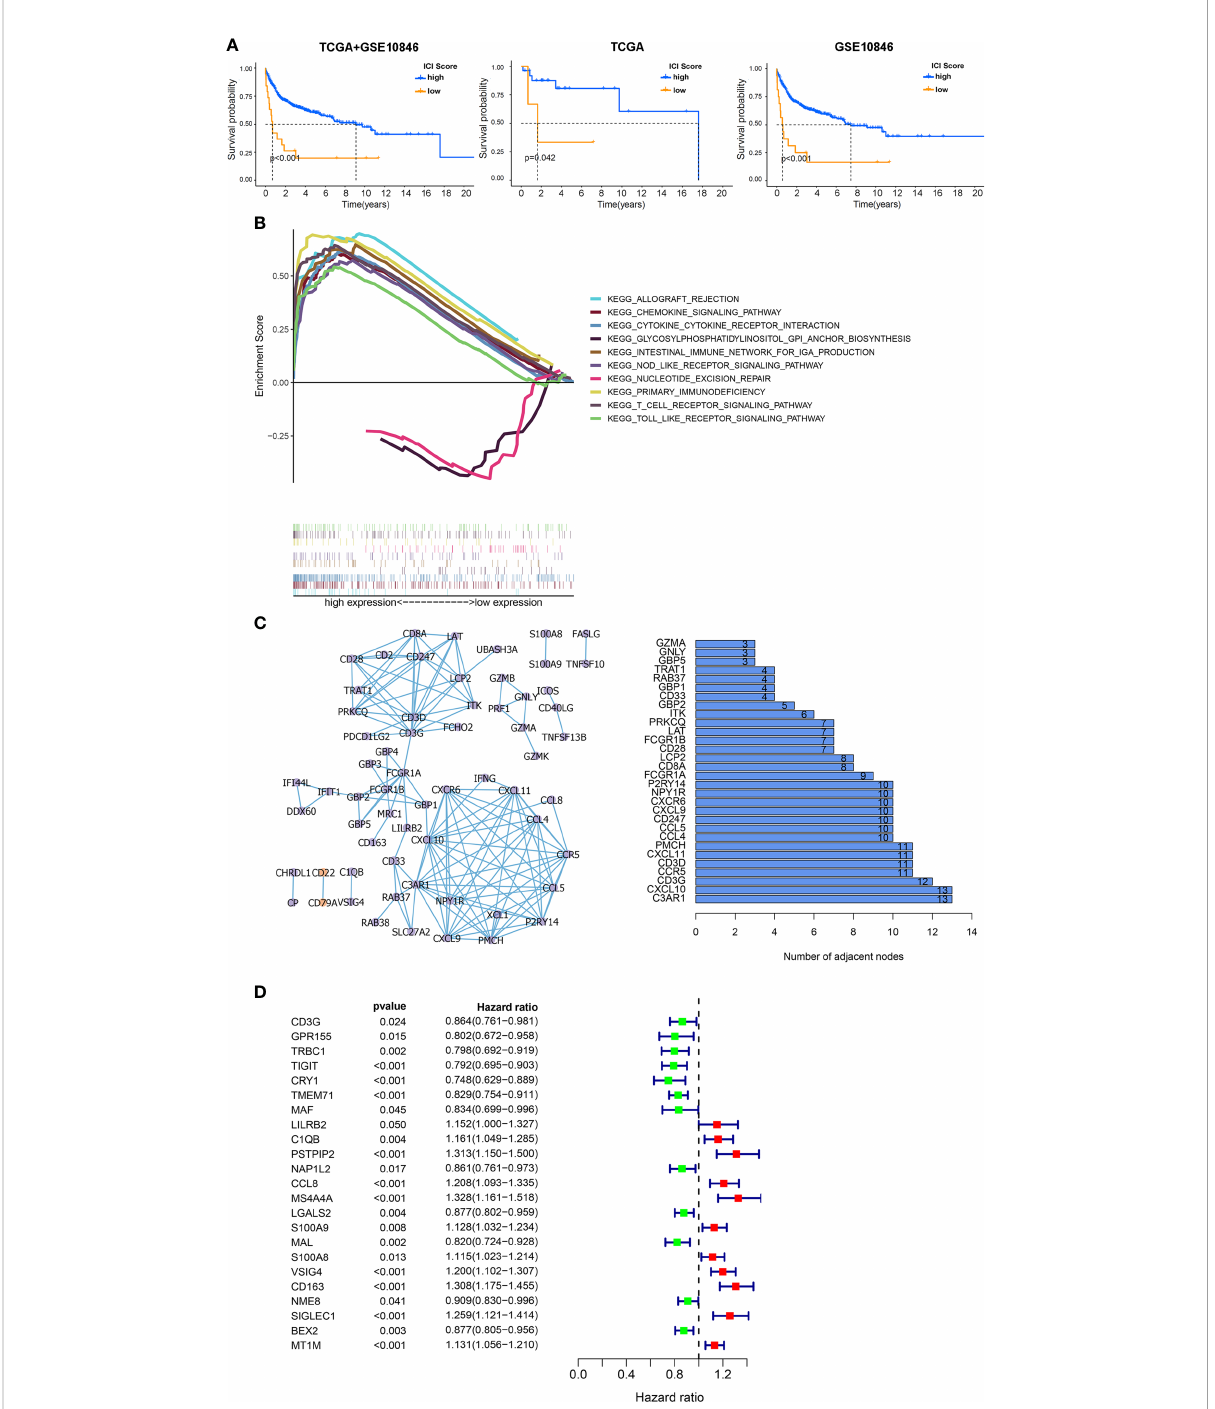
FIGURE 4 Functional analysis of DEGs among ICI clusters. (A) Kaplan – Meier survival analysis according to ICI scores. Left: the combination of the GSE10846 and TCGA databases. Middle: TCGA database. Right: GSE10846 dataset. (B) Multiple GSEAs were used to annotate the KEGG pathway enriched in high- and low-ICI score subgroups. (C) PPI network of hub genes (left: PPI network, purple: upregulated genes in tumor, orange: downregulated genes in tumor, right: bar plot demonstrating the number of adjacent nodes in the top 30 hub genes.). (D) Cox regressions were applied to detect the hazard ratios (HRs) of survival time. The con fi dence intervals are shown as the length of the line. Lines crossing HR = 1.0 indicates their insigni fi